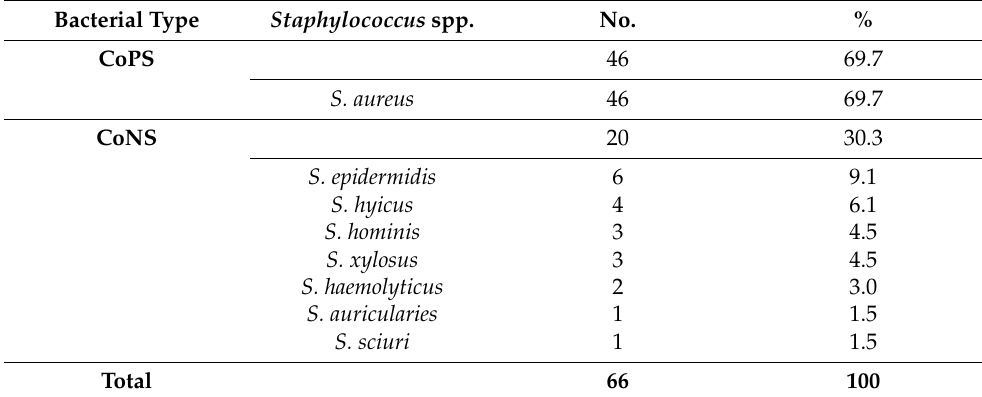
Table 1. Relative distribution of Staphylococcus spp. isolates collected from patients. Bacterial Type